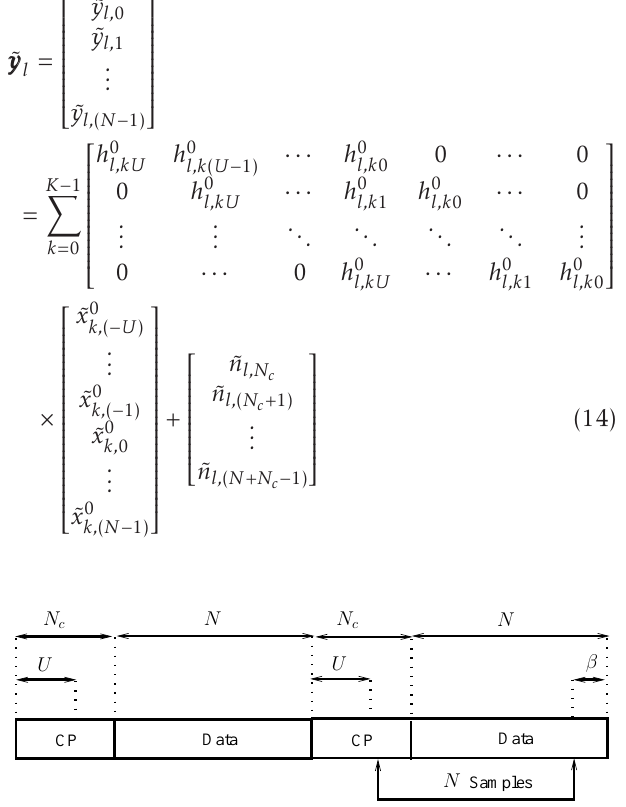
Figure 4. Illustration for the scenario of quai-synchronous sensing without ISI, where 0